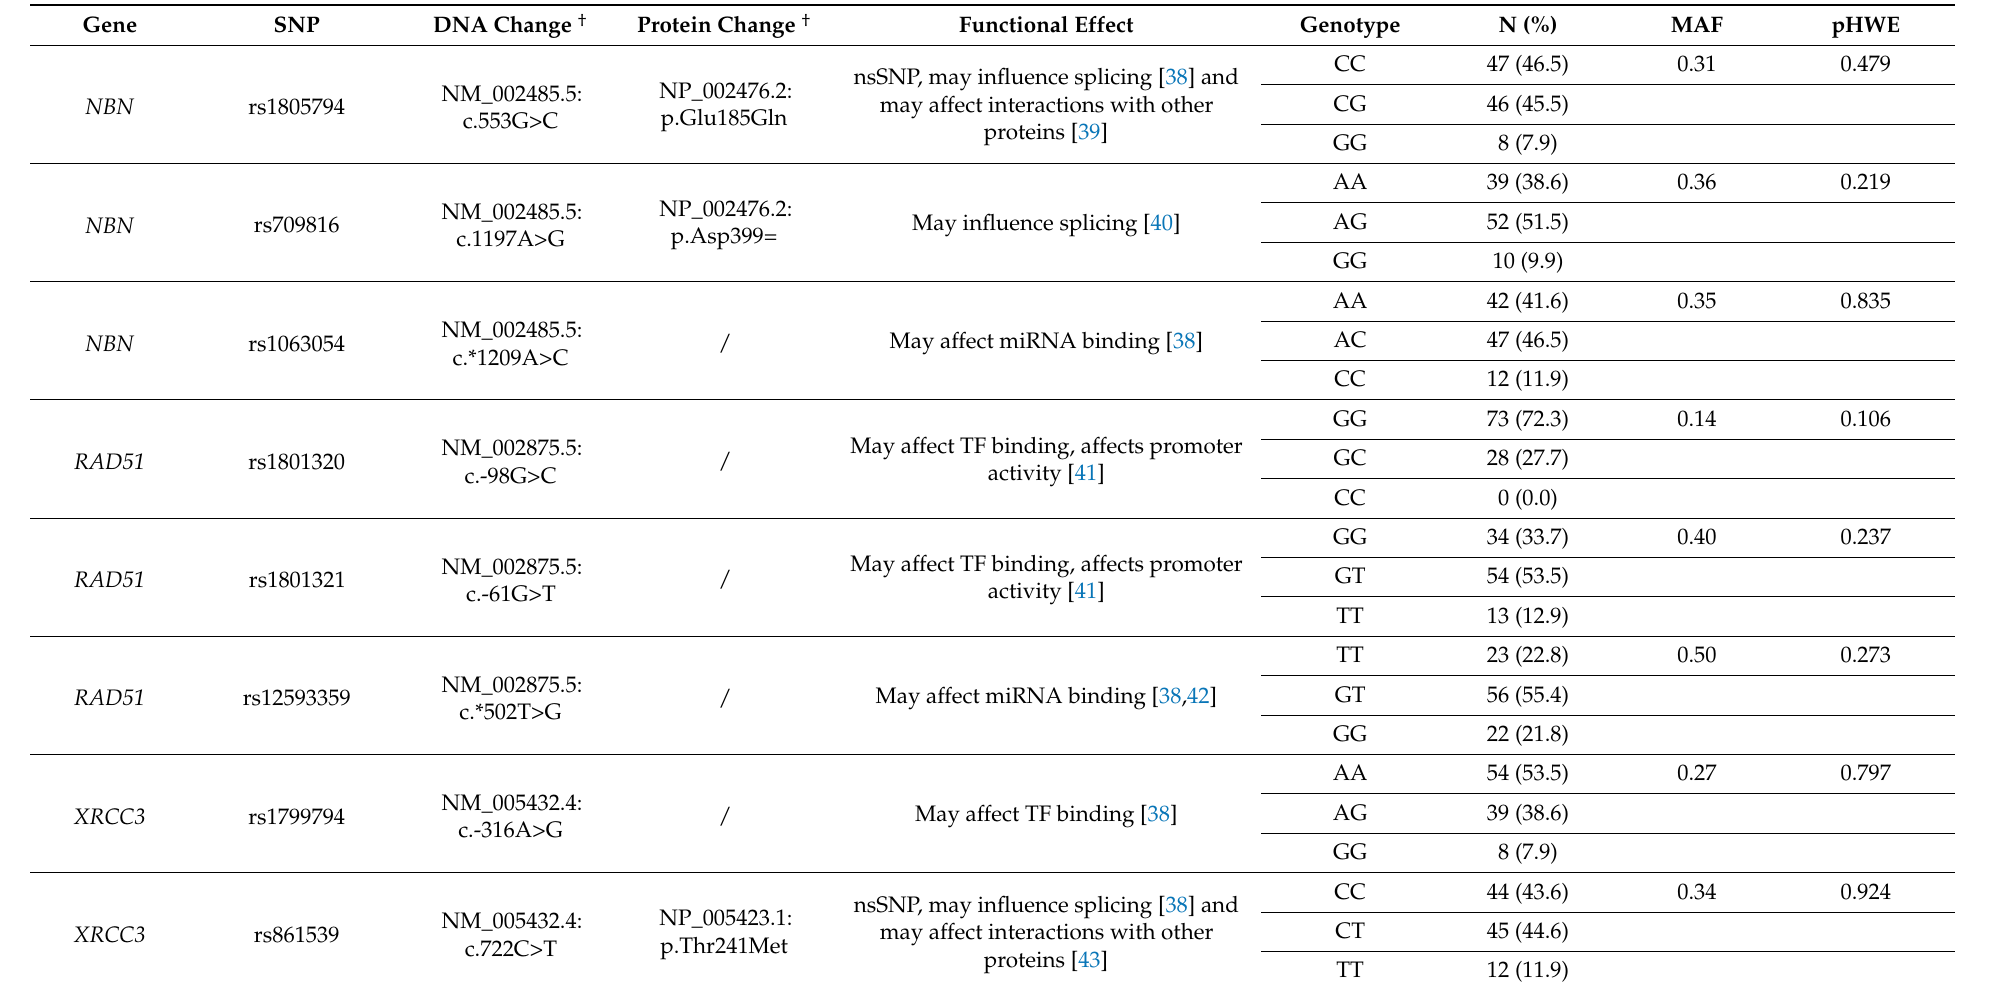
Table 4. Genotype frequencies of selected polymorphisms and their functional